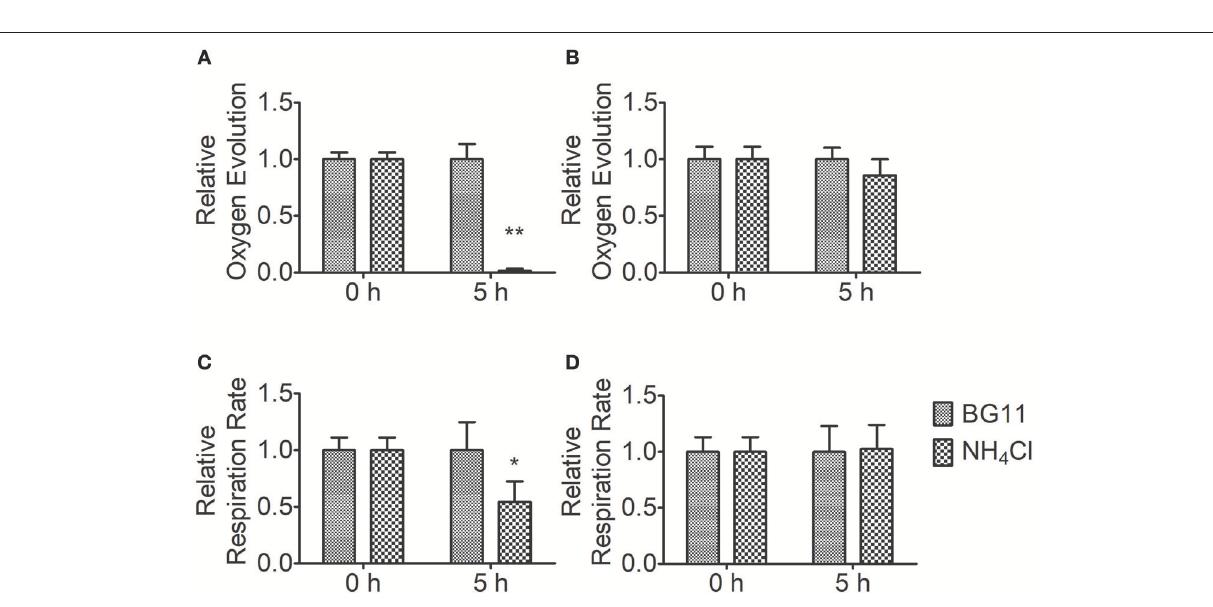
FACHB-1563, Mo and 9 o did not noticeably change